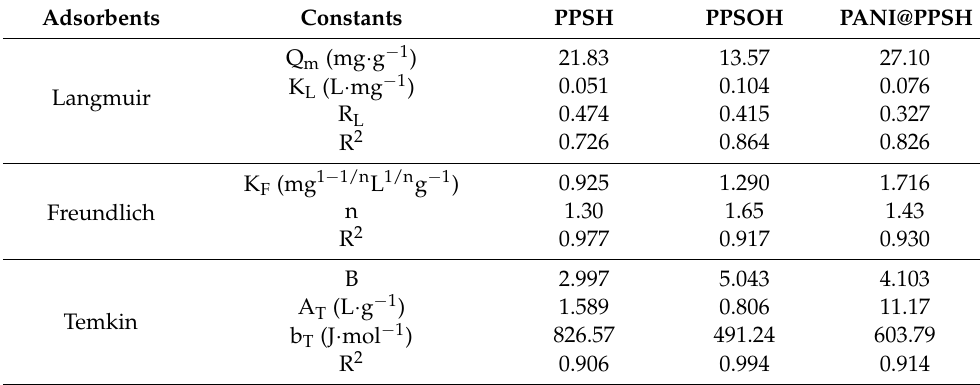
Table 3. Langmuir, Freundlich, and Temkin isotherms’ data for CR removal by samples at 298 K and pH: 6.5.